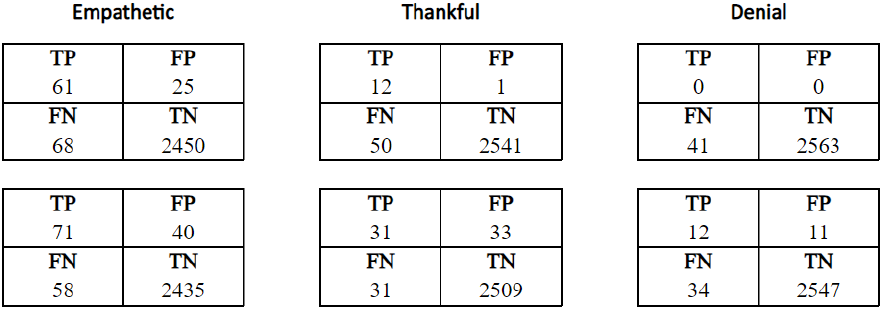
Figure 6. Confusion matrices of three minority classes before (first row) and after (second row) applying DWLF technique with MARBERT